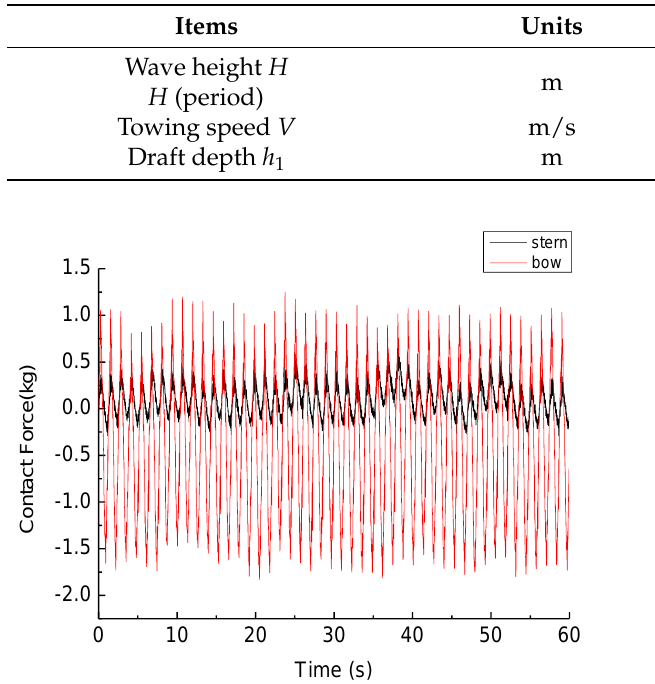
Table 5. Wet-towing conditions (wave height as main variable).